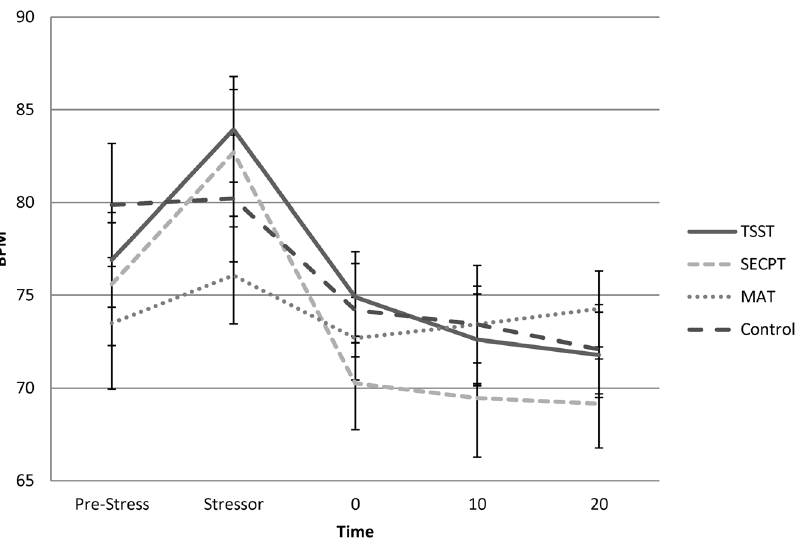
Fig. 3. Heart rate. Heart rate as a function of stress condition and time (means and standard errors) pre- stress, during the stressor, and at 0, 10, and 20-minutes post-stress. Across all Stress conditions, heart rate was higher than baseline during the Stress tasks, and lower than baseline at all time-points post-stress ( p , 0.01). Additionally, heart rate higher than baseline during the TSST and lower than baseline 10-30 min post-TSST ( p , 0.01). Heart rate was higher than baseline during the SECPT and lower than baseline at all time-points post-SECPT ( p , 0.01). Heart rate was lower than baseline during all time points post-Control task F (4,92) 5 9.121, p , 0.01. Heart rate did not change over time during the MAT.